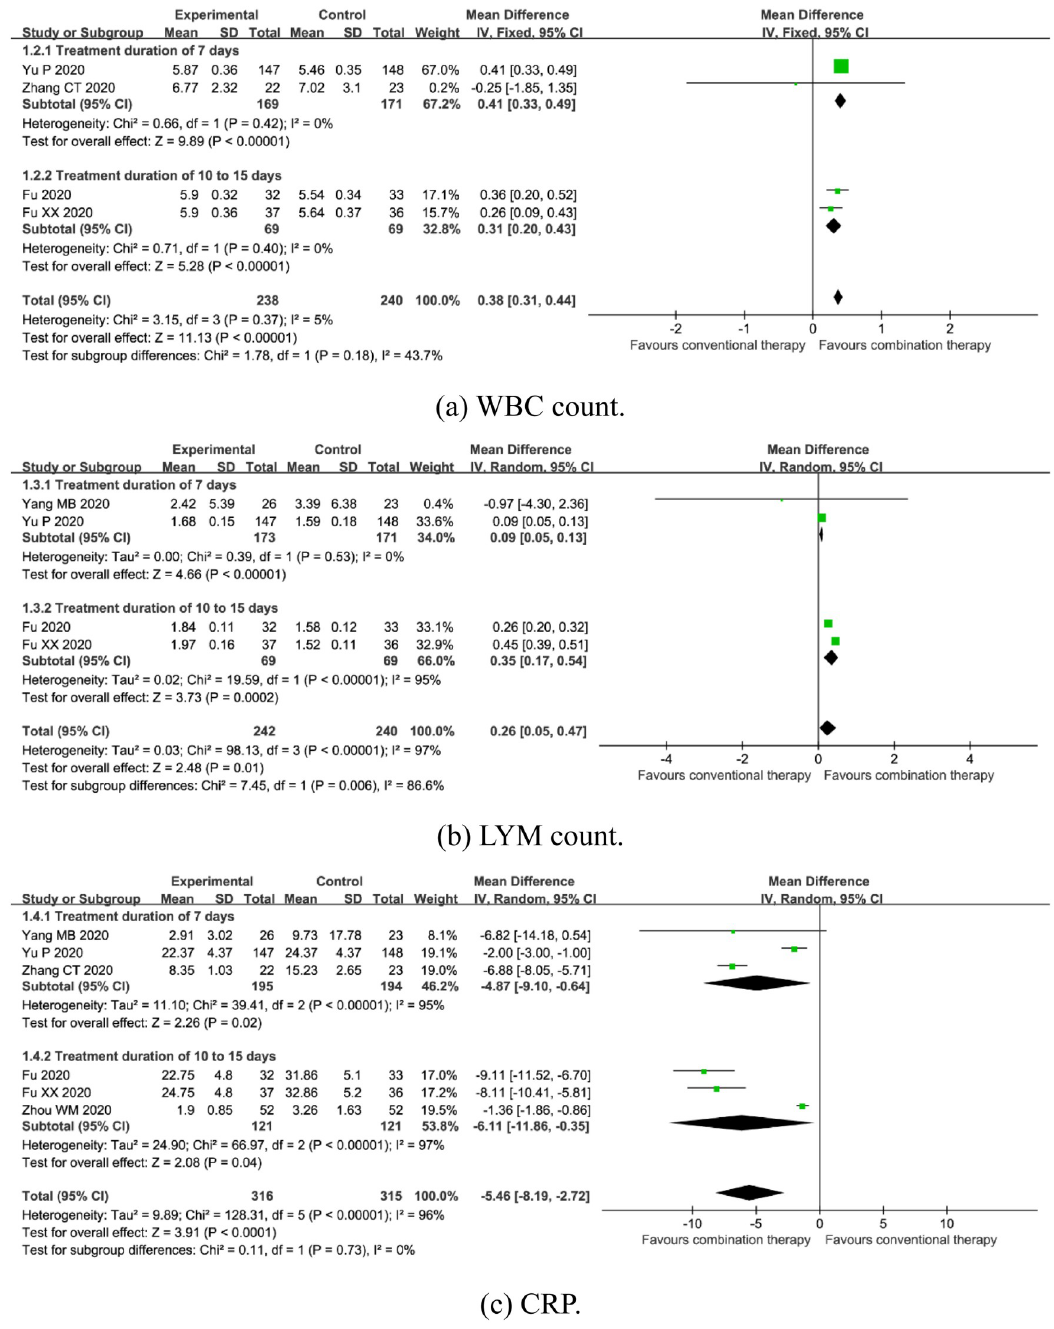
Fig 5. Forest plot of the effects of combination therapy for outcomes of (a) WBC count, (b) LYM count, (c) CRP.